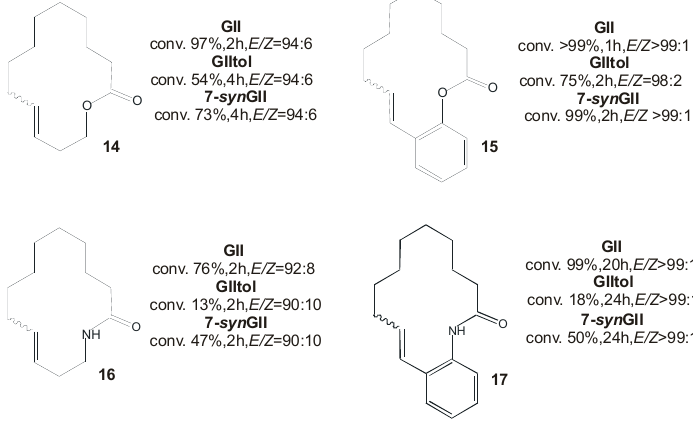
Figure 7. Macrocyclic RCM products 14 – 17 .